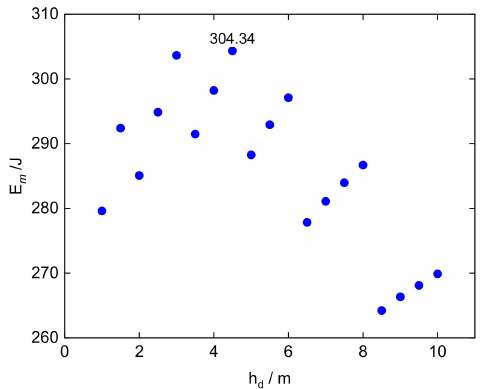
Figure 10. Average energy generation per unit length E m at di ff erent height combinations ( h u , h d